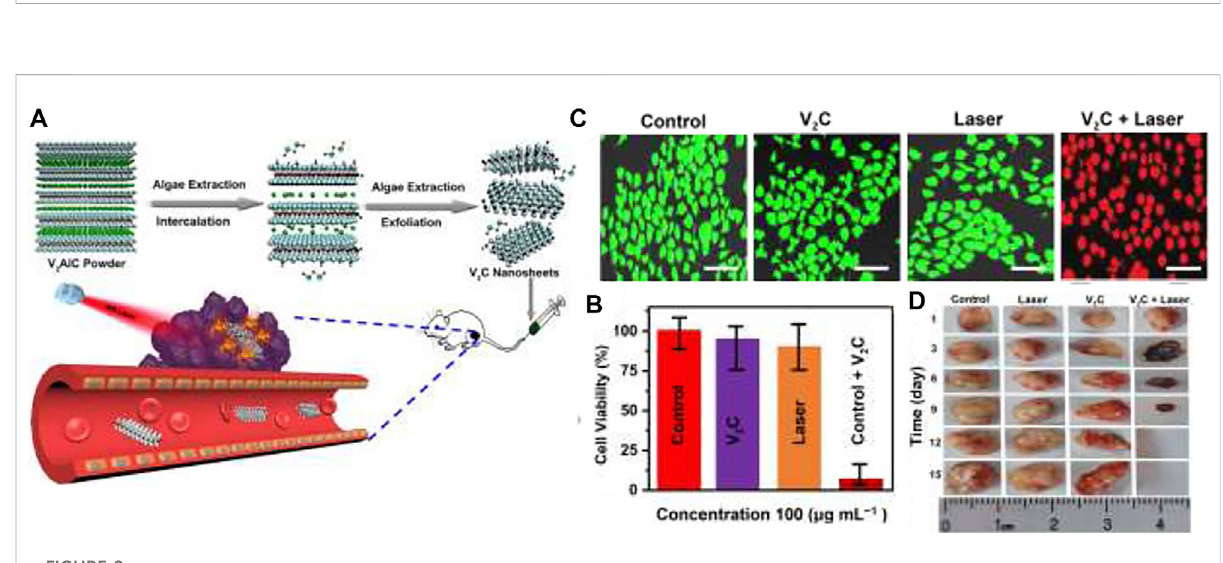
FIGURE 8 (A) Schematic representationofV 2 C-NSssynthesisandusages forPTT, (B) MTTmethod,and (C) resultofCalceinAM/PIdualcoloringofMCF-7 cell livability remedied with different treatment groups, (D) Tumor size photograph (Zada et al.,